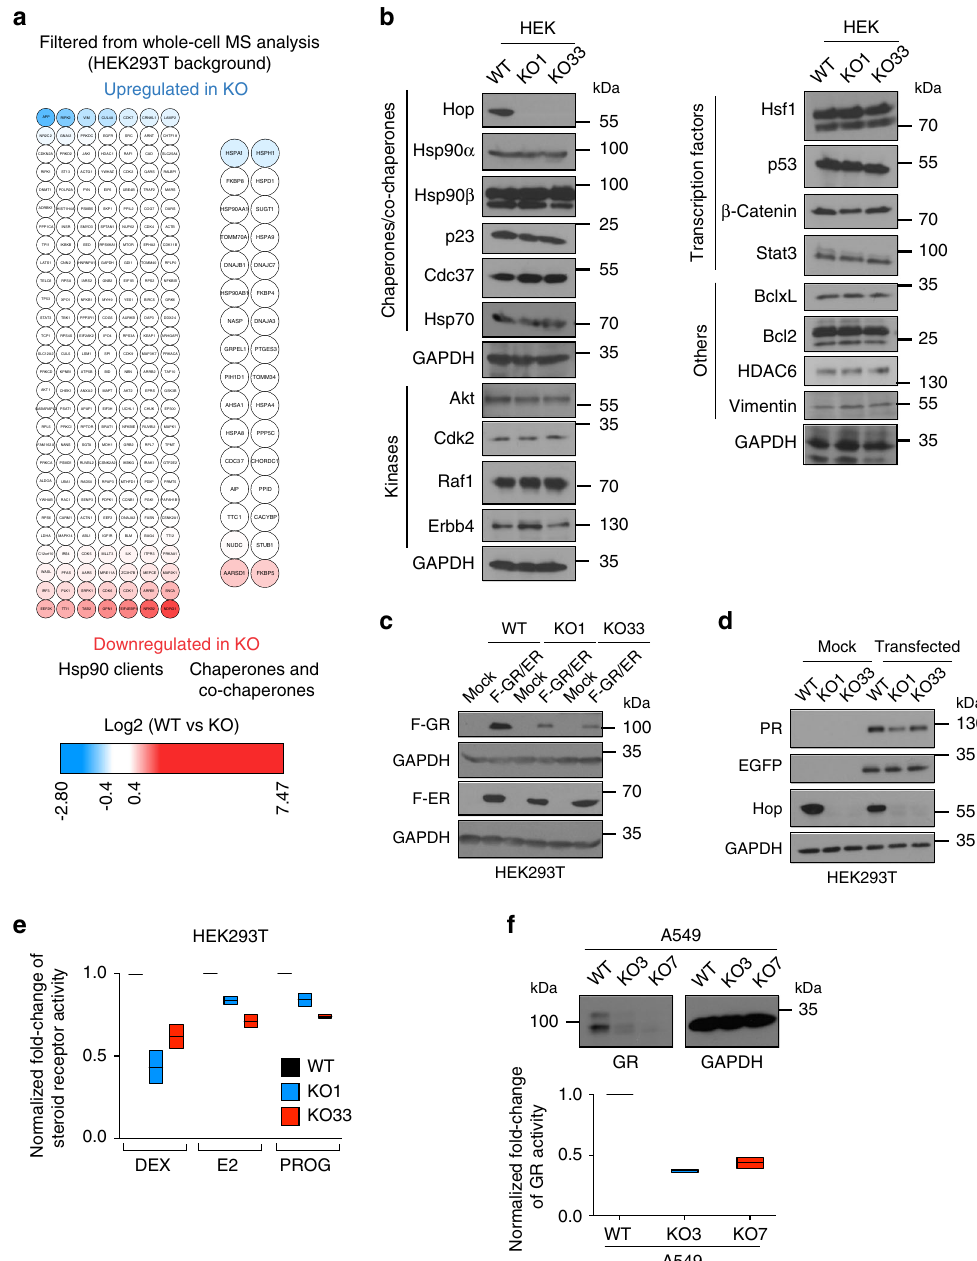
Fig. 7 Hop KO only affects few speci fi c Hsp90 clients. a Heat maps of the normalized fold changes of the levels of Hsp90 clients (left), and molecular chaperones and co-chaperones (right) identi fi ed by whole-cell MS analyses. b Immunoblots of Hsp90 clients, Hsp90 partners and co-chaperones ( n =